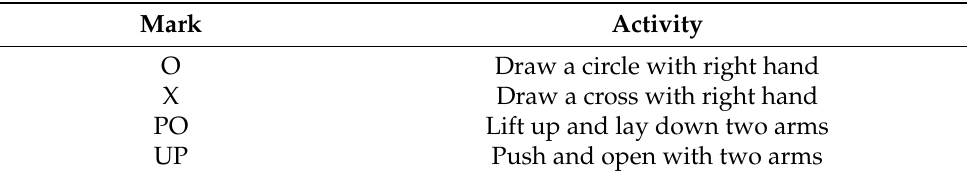
Table 1. Predefined